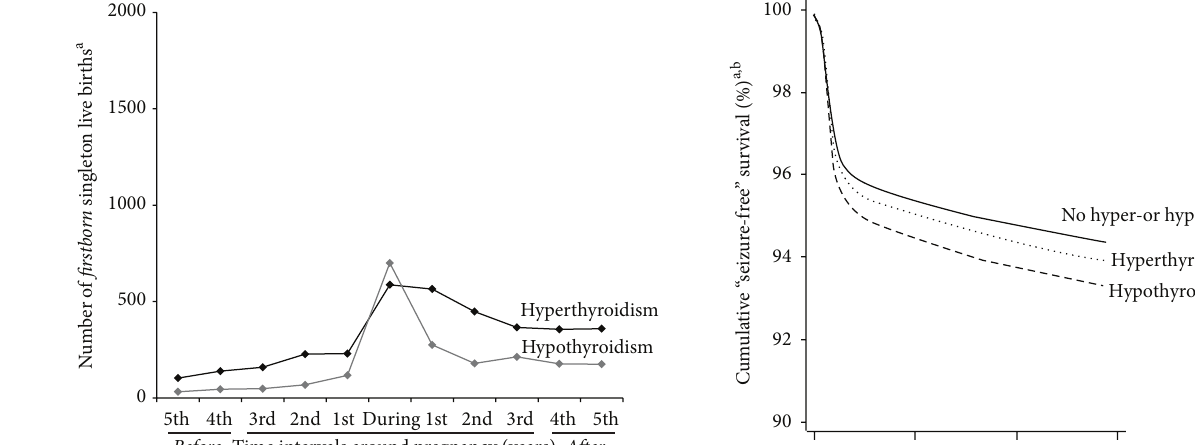
0 Figure 3: Cumulative percentages of children with no diagnosis of seizure (neonatal seizure, febrile seizure, or epilepsy) by follow- up time from birth of the child and maternal diagnosis of thy- roid dysfunction (none, hyperthyroidism, hypothyroidism). a Cox regression model. Outcome: a diagnosis of seizure (neonatal seizure, febrile seizure, or epilepsy). Exposure: maternal diagnosis of hyper- thyroidism, hypothyroidism, or no maternal thyroid dysfunction. Diagnoses were registered in the Danish National Hospital Register beforeJanuary1,2007.Modelincludedgenderofthechild(boy/girl), following maternal variables obtained at the time of the child’s birth: age ( < 20, 20–24, 25–29, 30–34, 35–39, ≥ 40 years), parity including index pregnancy (1, 2, 3, ≥ 4), cohabitation (married/not married), income (1st, 2nd, 3rd, 4th quartile), origin (born in Denmark/not born in Denmark), residence (East/West Denmark), and maternal diagnosis of febrile seizure and/or epilepsy registered in the Danish National Hospital Register (DNHR) before January 1, 2007 (yes/no). b 317 cases were censored (febrile seizure 𝑛 = 89 , epilepsy 𝑛 = 224 , and epilepsy and febrile seizure 𝑛 = 4 ), all because of emigration. Distribution of the censored cases by exposure group: no hyper- or hypothyroidism ( 𝑛 = 306 ), hyperthyroidism ( 𝑛 = 8 ), and hypothyroidism ( 𝑛 = 3